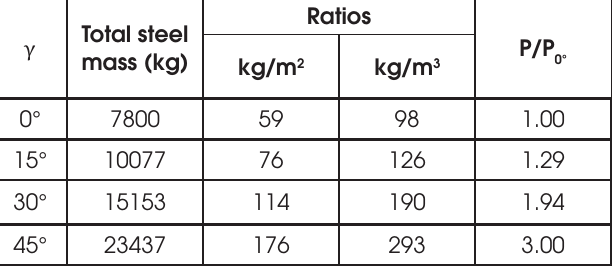
Total steel mass and ratios for flat bridges without lateral